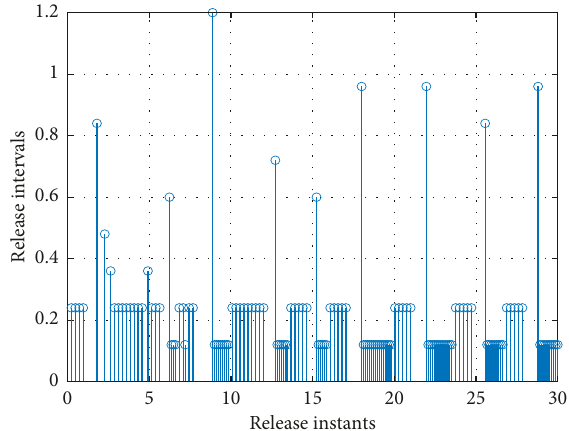
Figure 5: Release instants and time intervals.